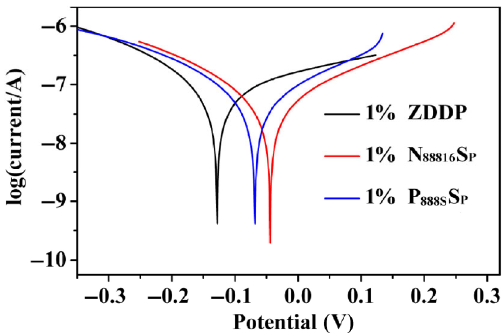
Fig. 9 Polarization curves of Q235 carbon steel in ethanol using 1 wt% ZDDP, 1 wt% N 88816 S P , and 1 wt% P 888S S P as the corrosion inhibitors.